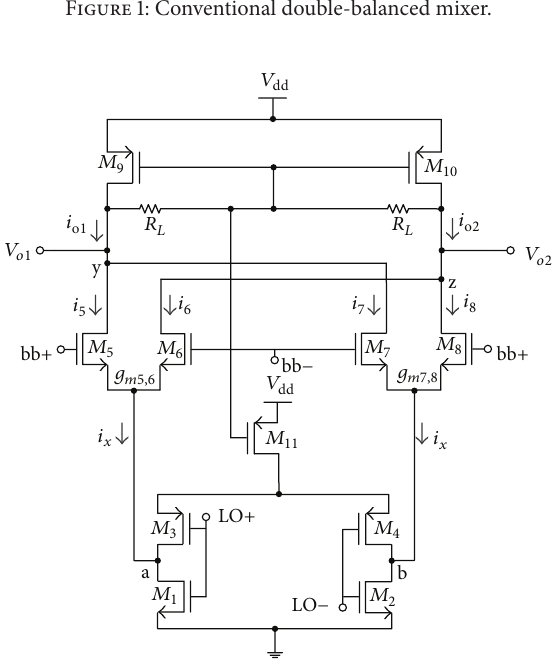
Figure 2: Proposed upconversion